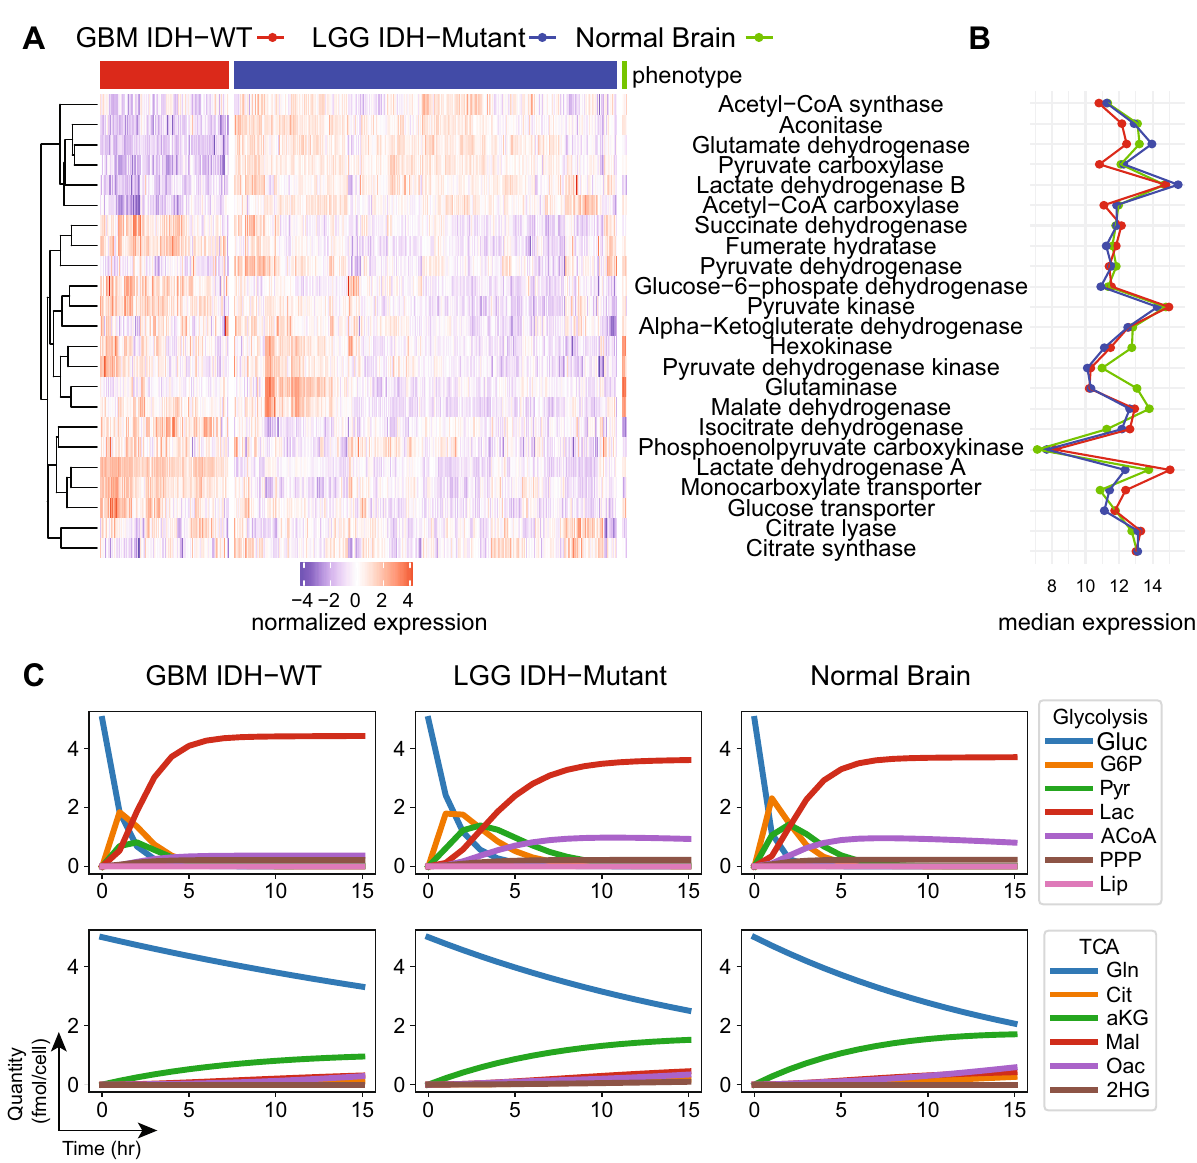
Figure 5. Metabolic phenotypes of patient derived samples. ( A ) Patient-derived mRNA expression data from The Cancer Genome Atlas of genes encoding for TCA and Glycolysis enzymes were processed and aggregated to estimate enzyme levels for three cohorts: Glioblastoma (GBM) samples with IDH-WT phenotype, Lower Grade Glioma (LGG) Samples with IDH-Mutant phenotype, and Normal Brain samples; displayed are across- samples-normalized expression heatmaps. ( B ) Estimated median expression of the enzymes for each cohort. ( C ) Using the experimental model flux rates from Grassian et al. 14 as the predicted GBM IDH WT rates, the flux rates for the other two cohorts were estimated using the ratios of the expression between GBM IDH-WT and LGG IDH-Mutant, and between GBM IDH-WT and Normal Brain. The PRISM models were instantiated with corresponding rates. Glucose and glutamine are initiated at maximum quantity 5 (fmol/cell) and all other species at